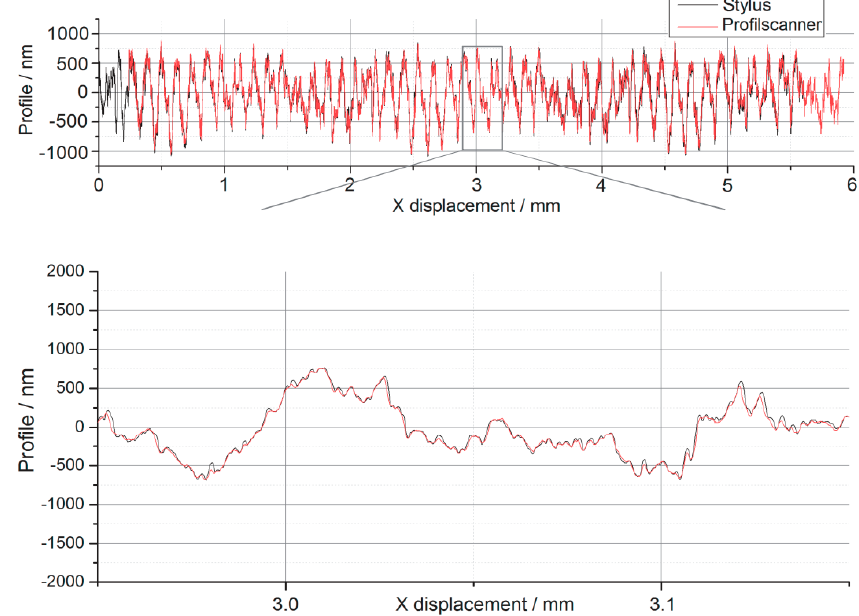
Figure 32. Comparison of stitched roughness measurement of the Profilescanner (red) and a roughness measurement nearly at the same position with PTB’s traceable roughness measuring stylus instrument (black).